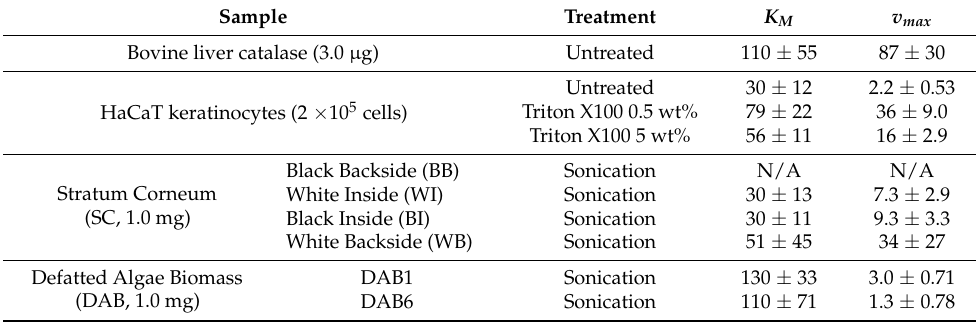
Table 1. Apparent kinetic parameters of neat catalase and catalase in various biological systems, including keratinocytes exposed to different treatment protocols, stratum corneum (SC) samples with visually different melanin contents, and defatted algae biomass (DAB) samples. Linear extrapolations were used to determine the apparent Michaelis constants K M (mM H 2 O 2 ) and the apparent maximal reaction velocity v max ( µ M H 2 O 2 /s) according to Equation (6). All experiments were performed in triplicates for each concentration of H 2 O 2 (i.e., at 10, 15, 25, and 50 mM H 2 O 2 ) in PBS at pH 7.5.